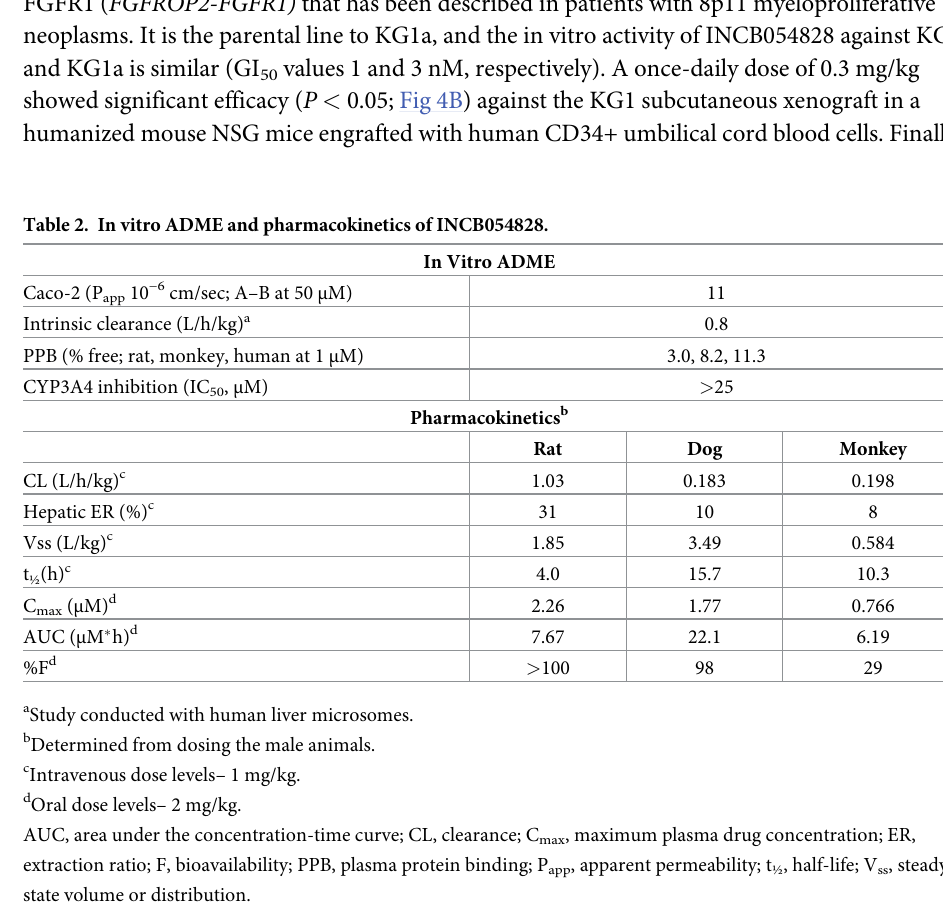
FGFR1 ( FGFROP2-FGFR1) that has been described in patients with 8p11 myeloproliferative neoplasms. It is the parental line to KG1a, and the in vitro activity of INCB054828 against KG1 and KG1a is similar (GI values 1 and 3 nM, respectively). A once-daily dose of 0.3 mg/kg 50 showed significant efficacy ( P < 0.05; Fig 4B) against the KG1 subcutaneous xenograft in a humanized mouse NSG mice engrafted with human CD34+ umbilical cord blood cells. Finally,